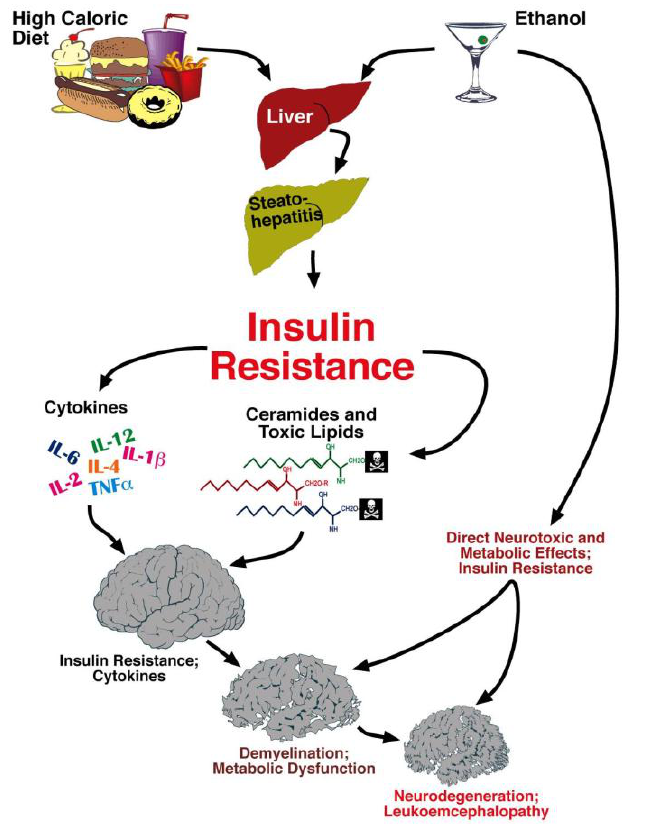
Figure 7. Liver-brain axis of neurodegeneration—Hypothesis. Progressive hepatic steatosis incites inflammation and pro-inflammatory cytokine activation. Attendant insulin resistance initiates a lipolysis and lipid disequilibrium cascade, leading to increased production and accumulation of ceramides. Ceramides are cytotoxic and promote insulin resistance, and their lipid solubility enables ready transfer across the blood-brain barrier to cause CNS insulin resistance and neurodegeneration with loss of neurons and oligodendrocytes. Ethanol’s lipid solubility enables it to exert direct neurotoxic effects, and cause brain insulin